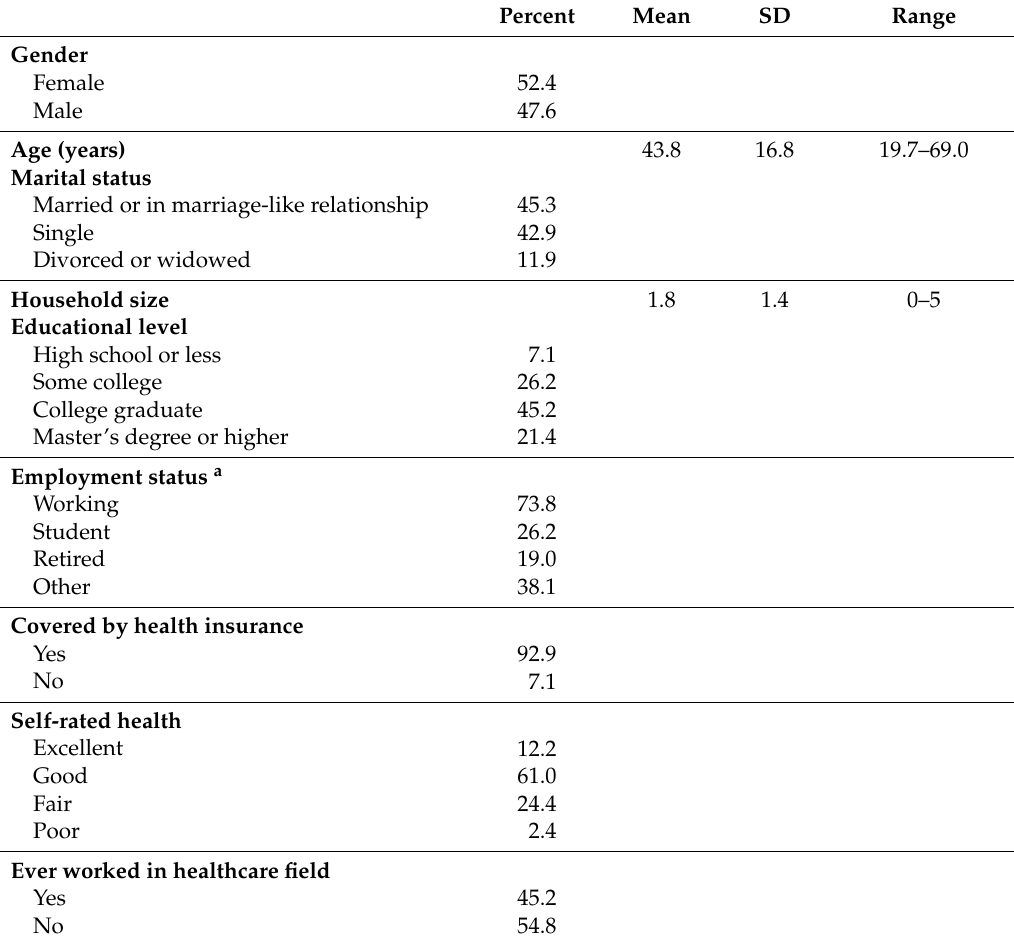
Table 1. Ego Descriptive Statistics ( n =